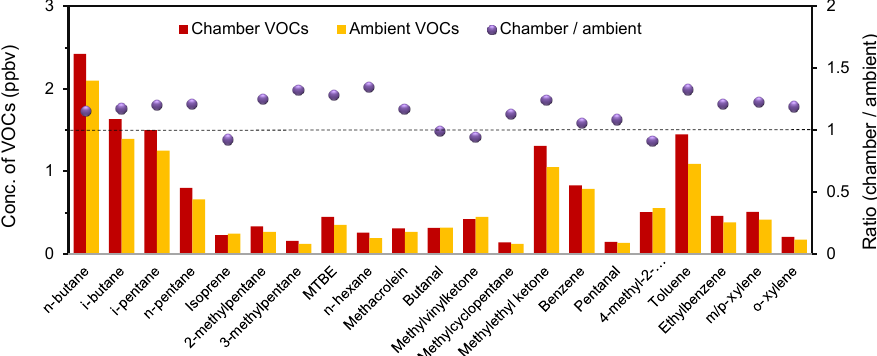
Figure 3. Comparison of VOC concentrations in the QUALITY chamber (red bar) and in the ambient air (yellow bar) before the start of BC ageing experiment. Purple cycles represent the ratio of each species in the reaction chamber to in the ambient air. Only the VOC species that contain four or more carbons with the concentration higher than 0.1ppb are shown in the figure.